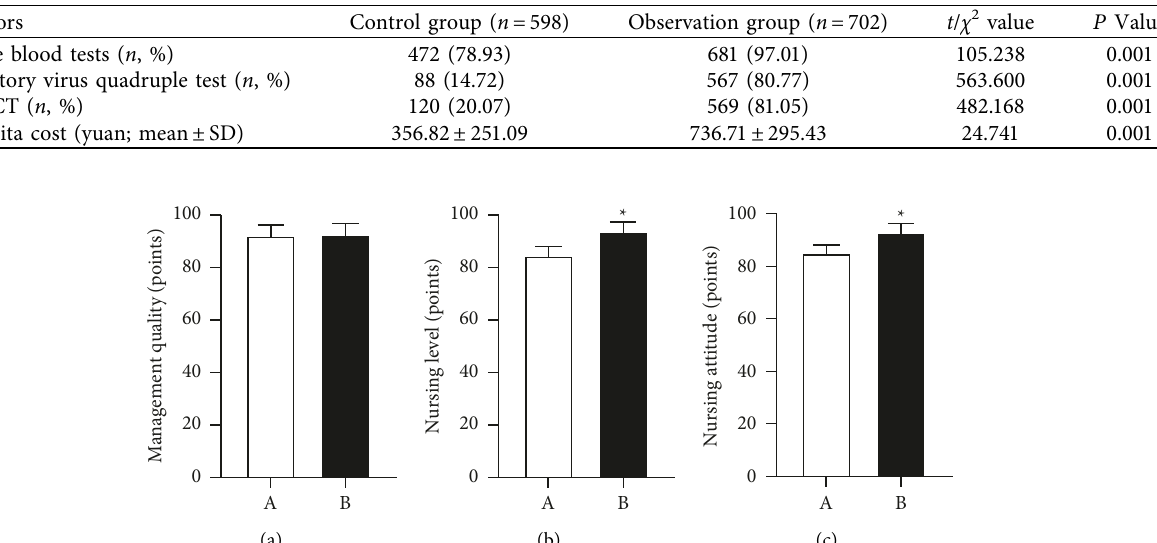
Table 2: Analysis of patients’ auxiliary examination results.